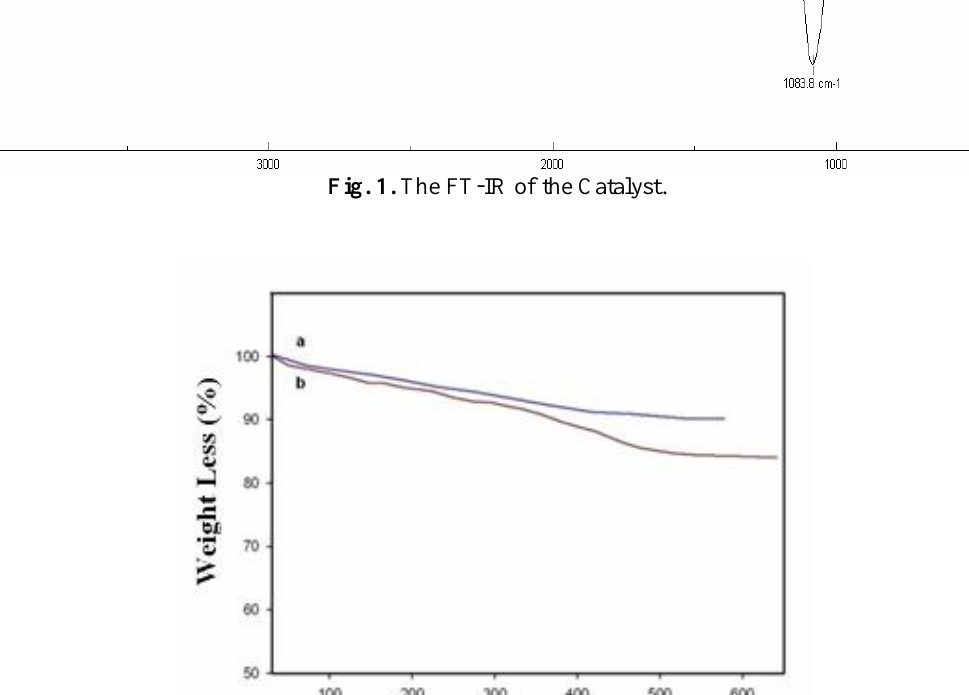
Fig. 2. The TGA graph of the